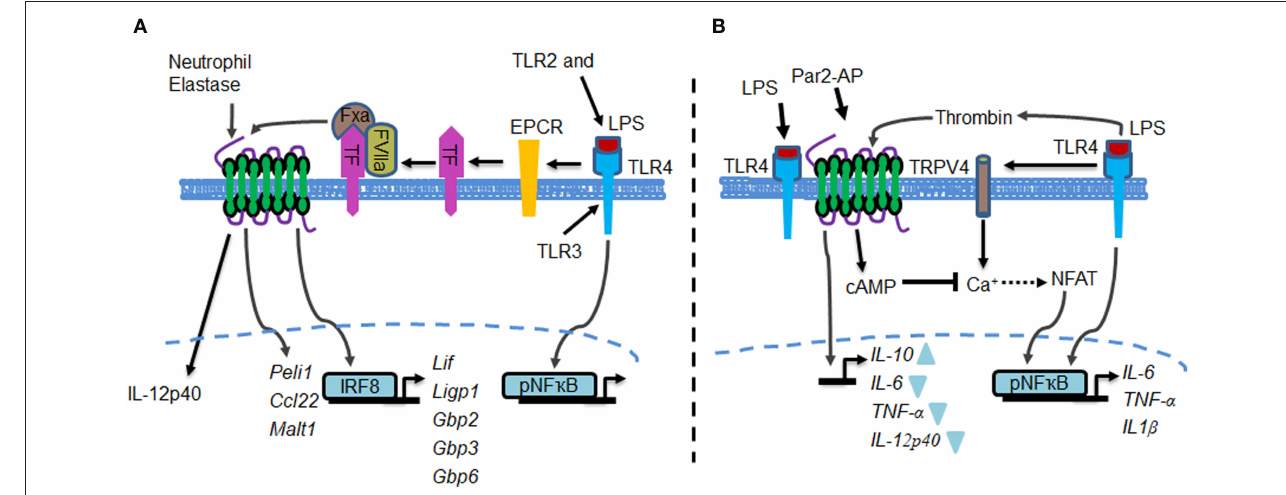
FIGURE 2 | Potential crosstalk models between TLR4 and PAR2. (A) PAR2 transactivation via EPCR and neutrophil elastase augments LPS-TLR4 inflammatory signaling. Tissue factor activates PAR2 via EPCR. TLR4-EPCR-mediated activation of PAR2 upregulated the expression of Peli1, Ccl22, and Malt1. Elastase secreted from neutrophils may cleave PAR2 to induce IL-12p40 generation in macrophages. Also, TLR2 and TLR3 may contribute to PAR2 regulation of TLR4 signaling. (B) PAR2 suppresses TLR4 inflammatory signaling, thereby facilitating resolution of lung injury. Thrombin secreted during TLR4-induced lung injury directly activates PAR2. PAR2 mediates the generation of cAMP, which suppresses TRPV4-induced Ca 2 + entry. Deletion of PAR2, hence elimination of cAMP generation, fails to suppress Ca 2 + entry via TRPV4, leading to protracted NFAT and NF κ B activities, resulting in long-lasting inflammatory injury. Additionally, simultaneous activation of PAR2 and TLR4 in peritoneal macrophages enhanced IL-10 expression while the expression of TNF- α , IL-6, and IL-12p40 was